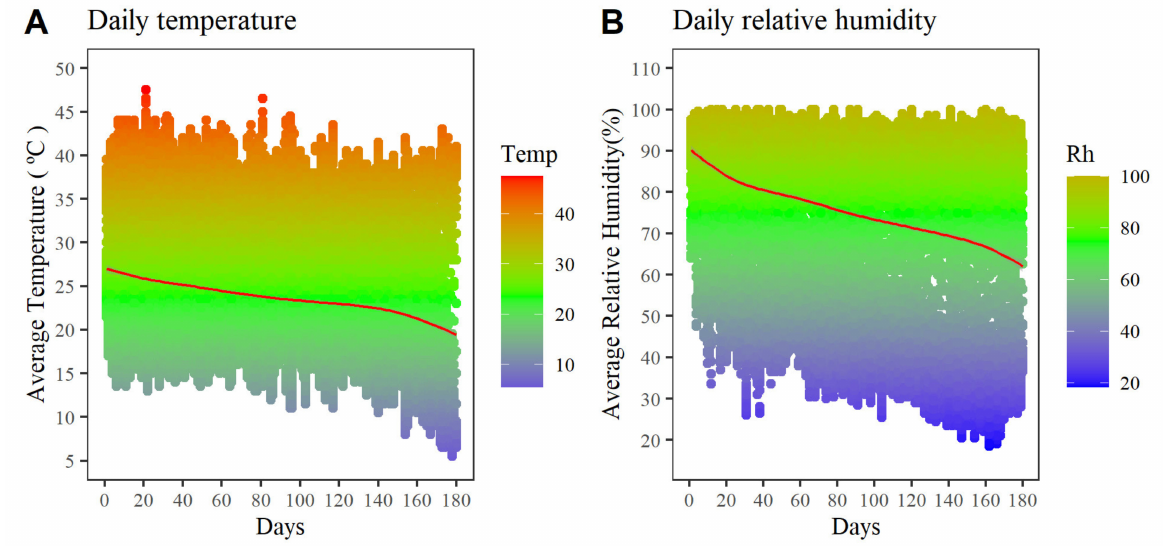
Figure 2. Evolution of temperature and relative humidity during the experiment at Yautepec Municipality, Morelos,